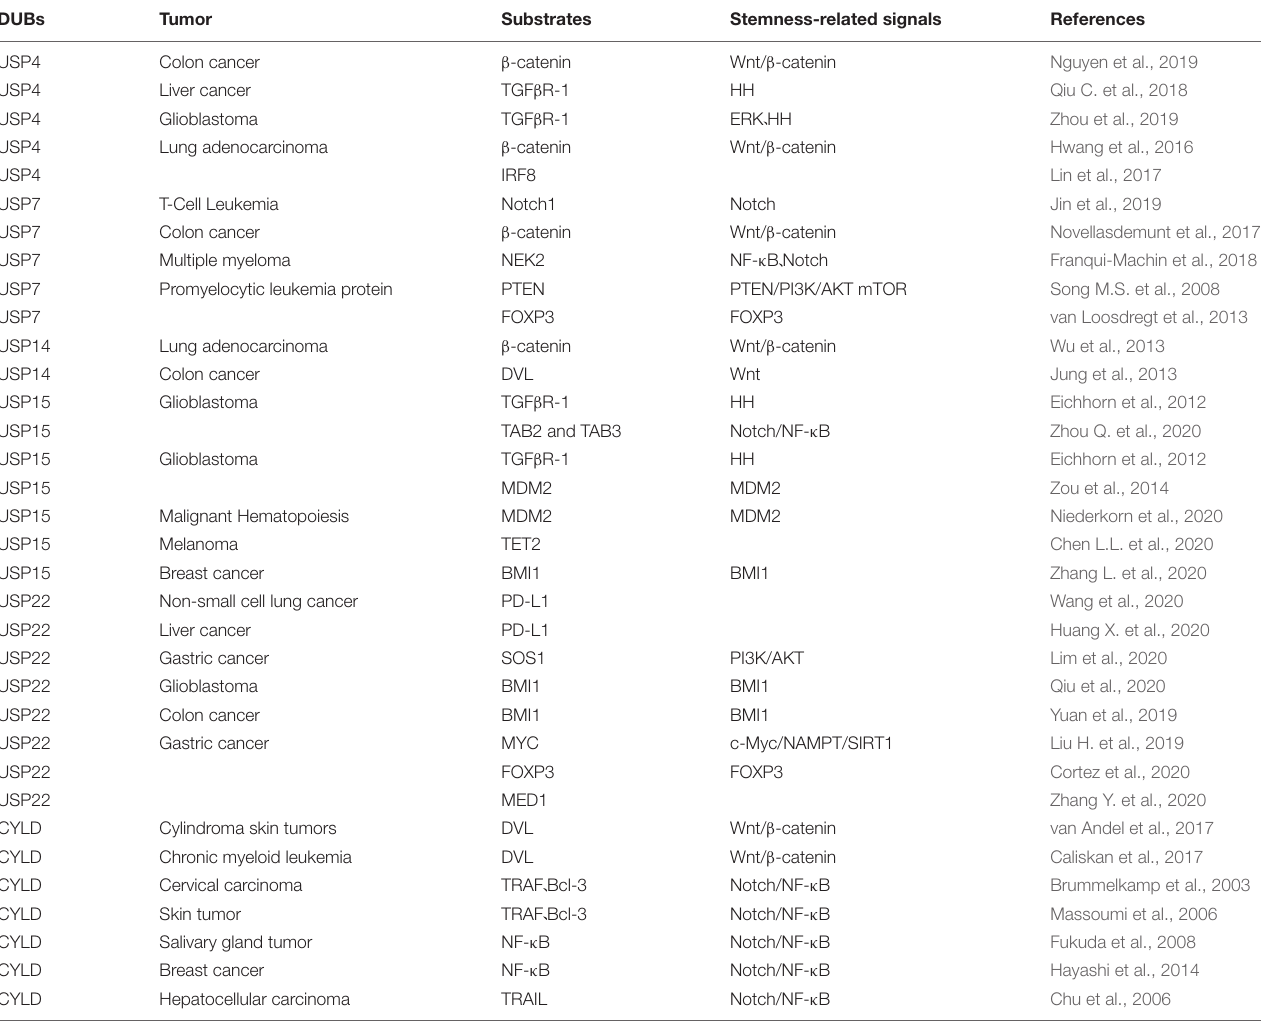
TABLE 1 | The DUBs associated with stem cell factors and the stemness-related signals. DUBs